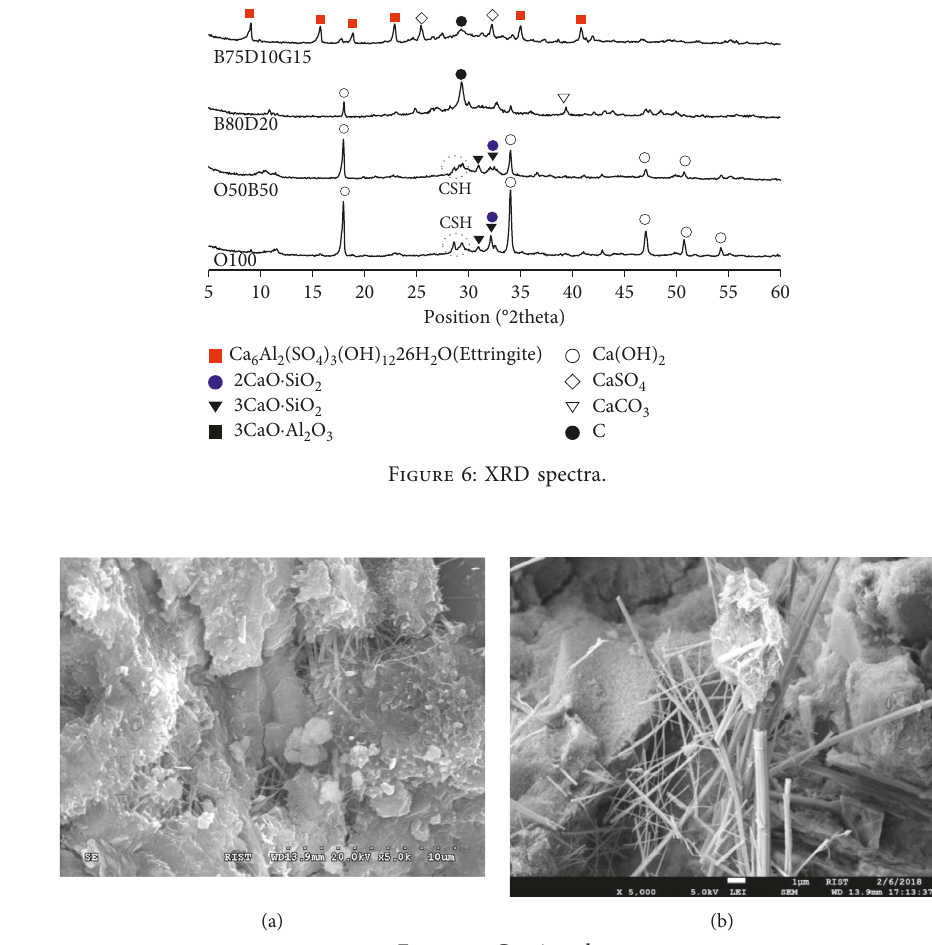
Figure 5: Hydration heat evolution.